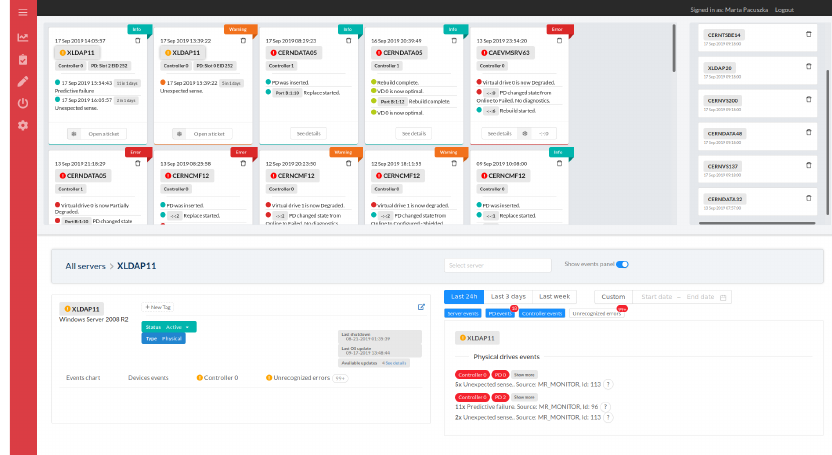
Figure 3. Server view in the main page of the